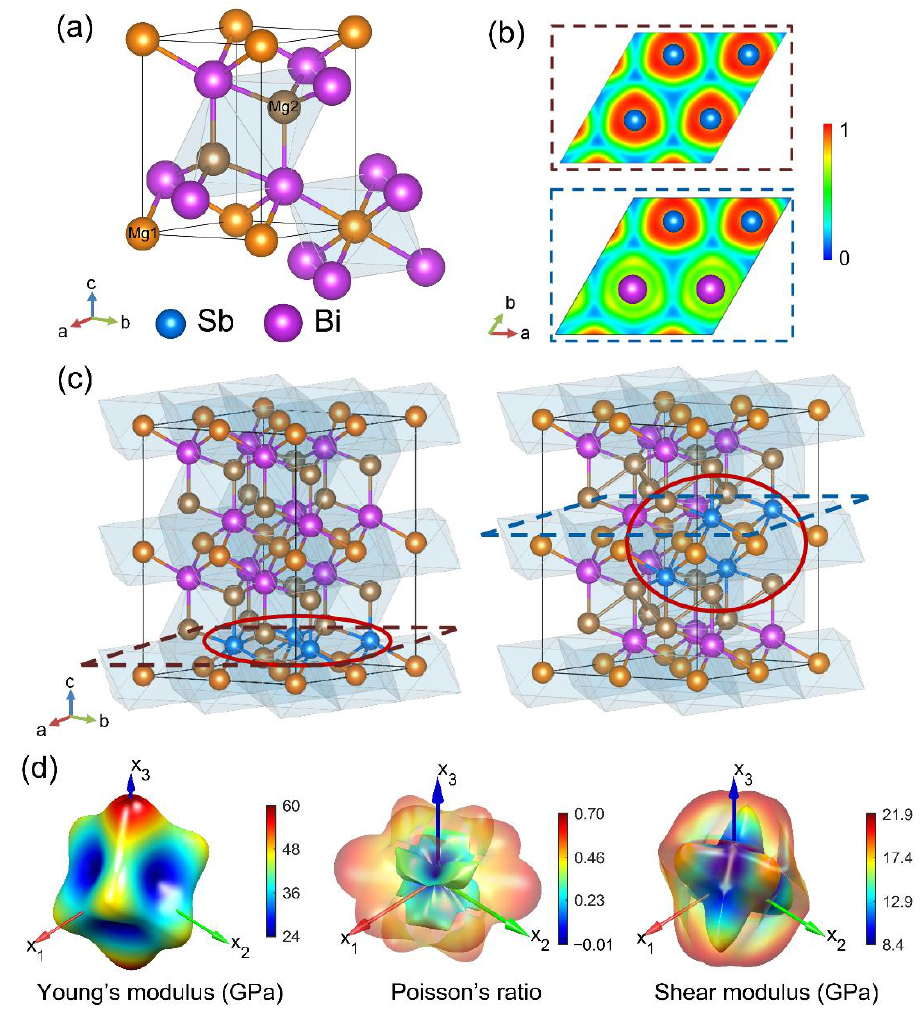
Figure 1. Structures with different sizes of supercell and elastic properties distribution for Mg 3 Bi 1.5 Sb 0.5 . ( a ) Crystalline unit for Mg 3 Bi 2-x Sb x . Bi sites are co-occupied by Bi and Sb atoms coinciding with the proportion. ( b ) Electron location function (ELF) of the same slice for different supercells with 10 atoms ( up ) and 40 atoms ( down ). ( c ) Structures with minimized energy for 10 atoms ( left ) and 40 atoms ( right ). For ease of comparison, the structure of 10 atoms is duplicated by 2 × 2 × 1. The observation slices for ELF in ( b ) are displaced by dashed border. Sb atoms distributions are highlighted by red circles. ( d ) three-dimensional orientation-dependent Young’s modulus, shear modulus, and Poisson’s ratio are derived from the elastic constant combination.